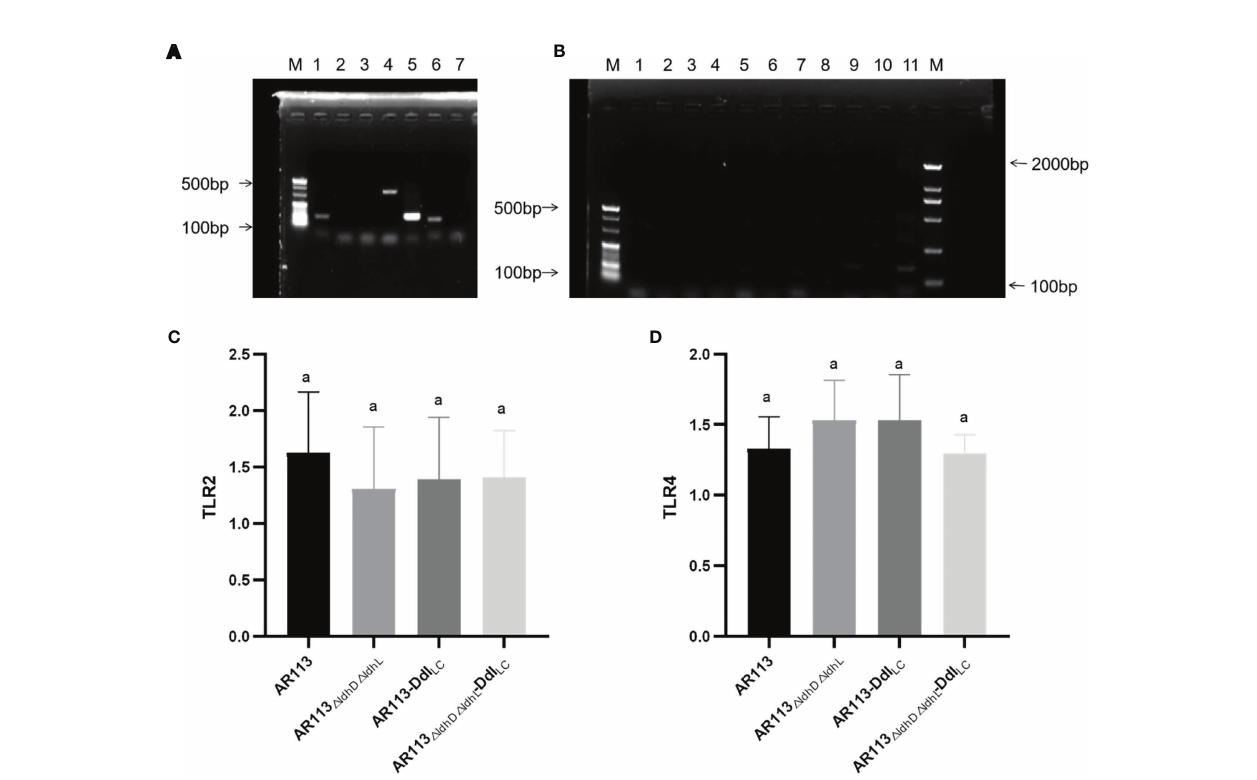
FIGURE 3 | Analysis of immunomodulatory signaling pathways affected by Ddl-overexpressing strains. (A) lane 1: p38, lane2: JNK, lane 3: IRAK1, lane 4: p38MAPK, lane 5: TRAF6, lane6: ERK; (B) lane 1: TLR1, lane 2: TLR3, lane 3: TLR5, lane 4: TLR6, lane 5: TLR7, lane 6: TLR8, lane 7: TLR9, lane 8: I kk - b , lane 9: I kk - g , lane 10: TRIF, lane 11: NF- kb P56; (C) RT-PCR of TLR2; (D) RT-PCR of TLR4. The statistical analyses were assessed using one-way ANOVA. Data are represented as means ± standard deviations (n = 7). Data indicated with different letters differ signi fi cantly (P <